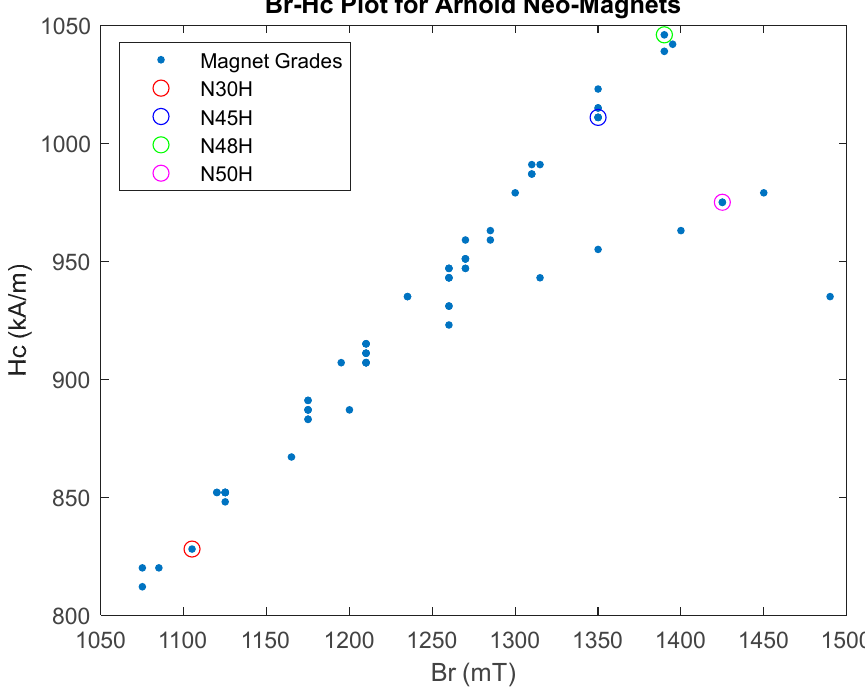
Figure 10. Remanence vs. Coercivity plot for different Neo-Magnet Grades -Separate cases for model validation.